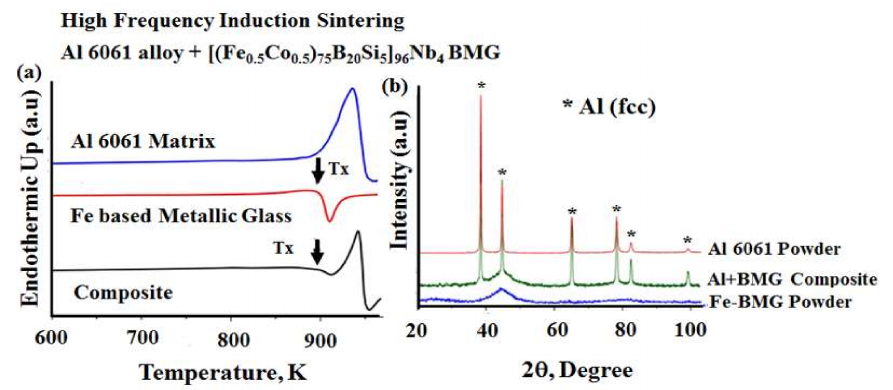
Figure 8. ( a ) Differential scanning calorimetry thermograms and ( b ) X-ray diffraction patterns of aluminum 6061 alloy, iron–cobalt (FeCo) based metallic glass and Al6061 alloy with [(Fe 0.5 Co 0.5 ) 75 B 20 Si 5 ] 96 Nb 4 composite prepared by high frequency induction heat sintering [31]. (© 2012, Elsevier. Used with